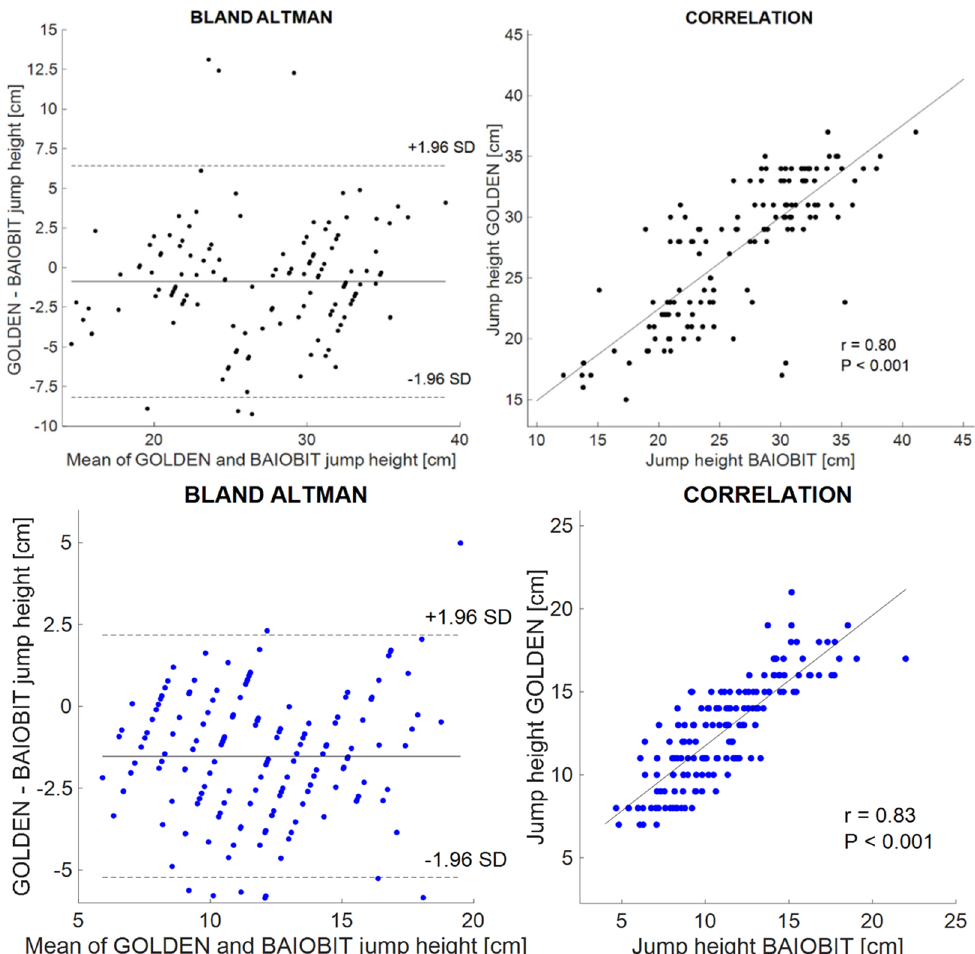
Figure 4. ( Top ) Double-leg CMJs on the left of the Bland–Altman plot comparing the optoelectronic system + force platform data (gold standard) vs. the Baiobit on the right of the correlation between the optoelectronic system + force plate and the Baiobit. ( Bottom ) Single-leg CMJs on the left of the Bland–Altman plot comparing the optoelectronic system + force platform data (gold standard) vs. the Baiobit on the right of the correlation between the optoelectronic system + force plate and the Baiobit.